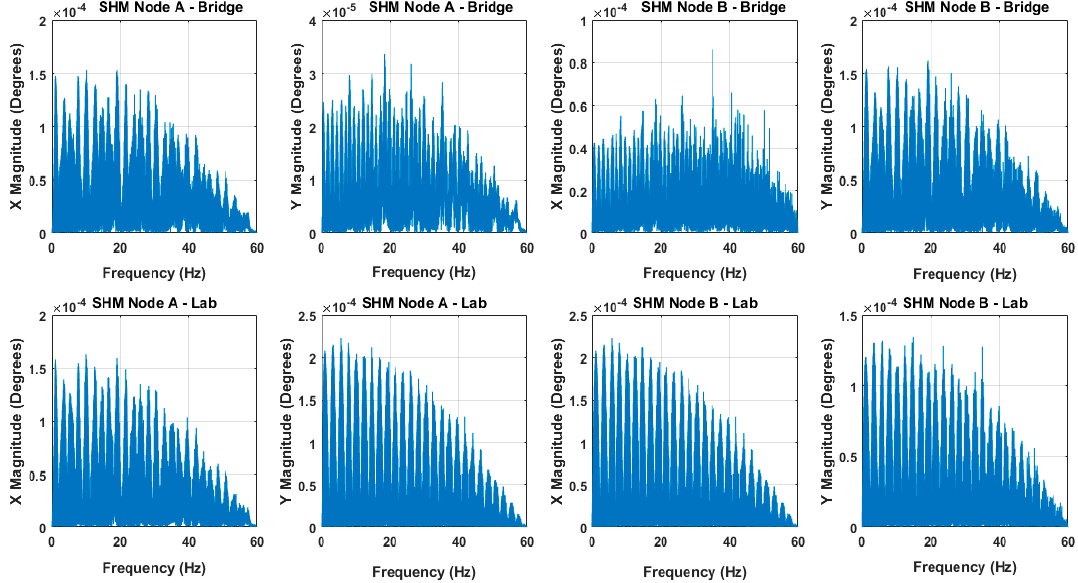
Figure 20. FFT of data gathered at two unique geolocations in five calendar months (80,000 samples).